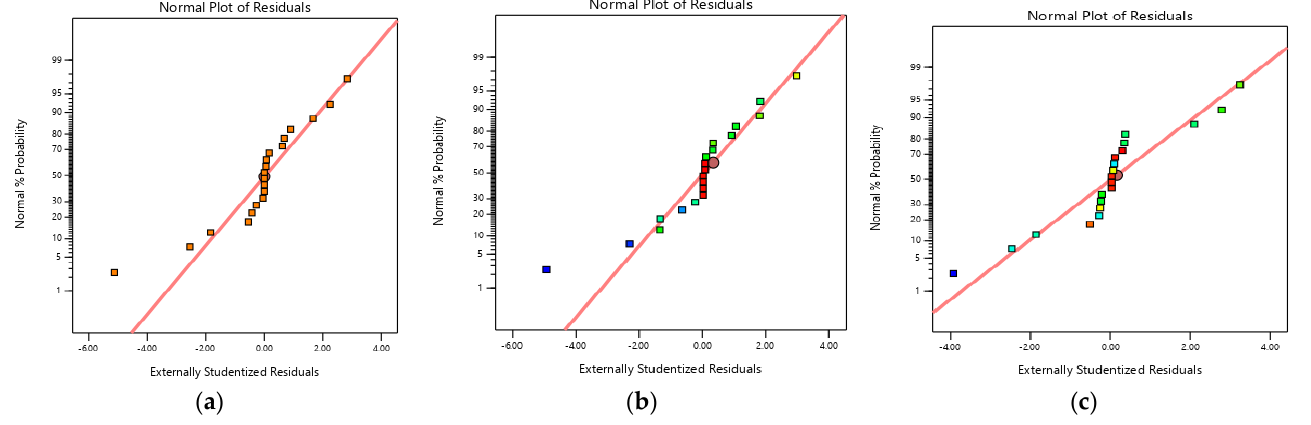
Figure 10. Studentized residuals and normal percentage probability plot for adsorbtion of Cr(VI) by ( a ) biomass; ( b ) biochar; and ( c ) TiO 2 NC.